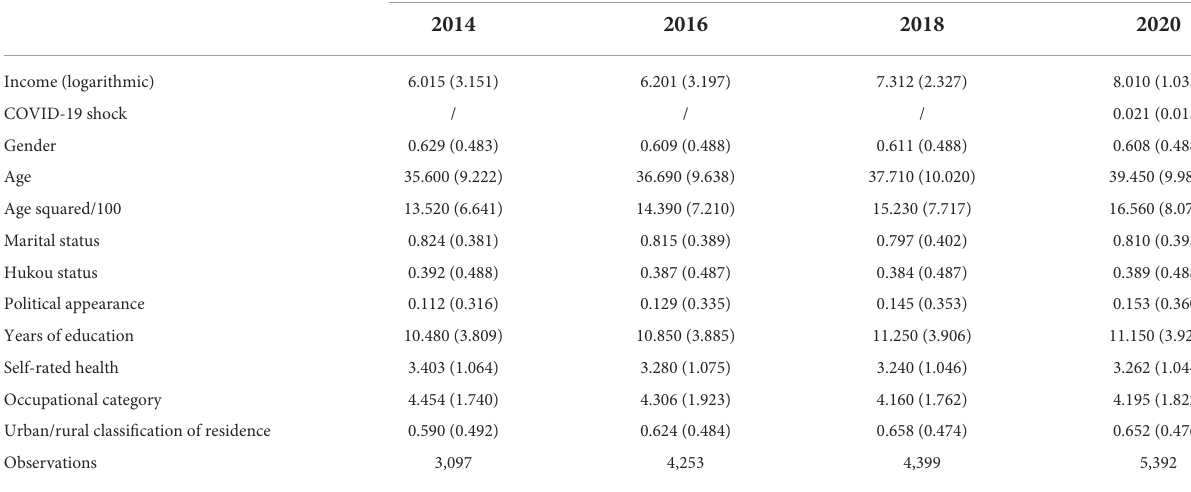
TABLE 2 Descriptive statistics of main variables.